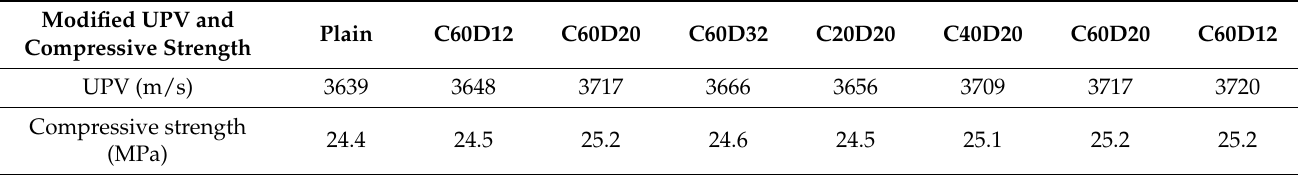
Table 5. Compressive strength and UPV data at 28